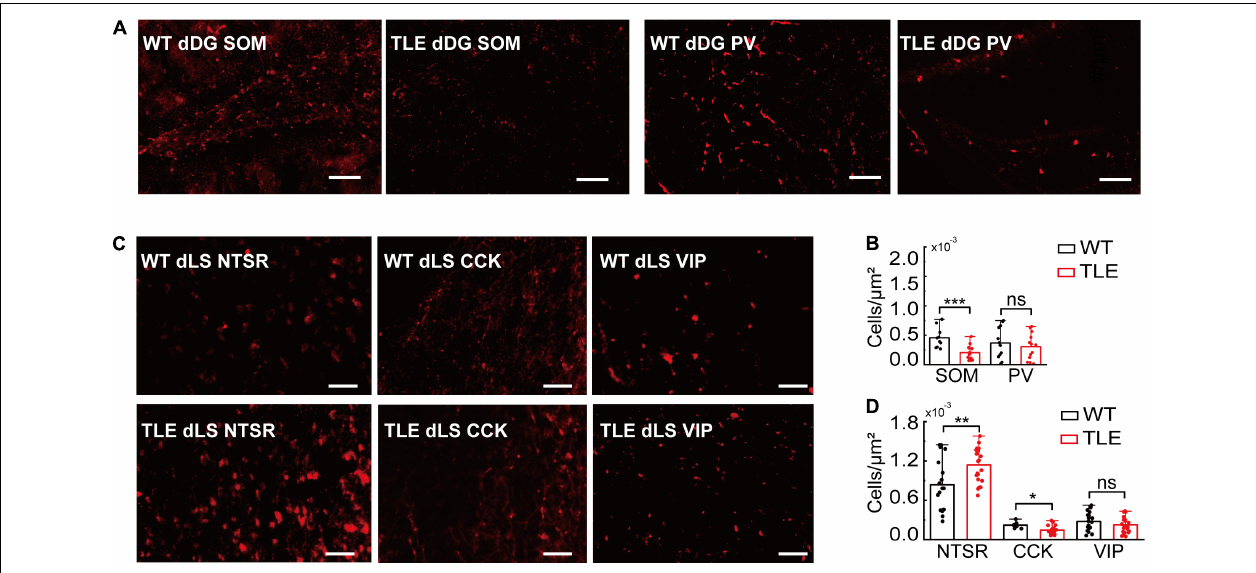
FIGURE 5 | Comparison of GABAergic neurons subtypes in WT vs. TLE. (A) Representative images of immunostaining of PV+ and SOM+ neurons in dDG of WT and TLE mice. Scale bar, 200 µ m. (B) The densities of SOM+ and PV+ neurons in dDG/CA3 (SOM+: WT, n = 6 mice, TLE, n = 6 mice; PV+: WT, n = 6 mice, TLE, n = 5 mice). (C) Representative images of immunostaining of NTSR+, CCK+, and VIP+ neurons in dLS of WT and TLE mice. Scale bar, 200 µ m. (D) The densities of NTSR+, CCK+, and VIP+ neurons in dLS (NTSR+: WT, n = 11 mice, TLE, n = 10 mice; CCK+: WT, n = 6 mice, TLE, n = 9 mice, VIP+: WT, n = 11 mice, TLE, n = 6 mice) (Error bars represent s.d; * p < 0.05; ** p < 0.01, *** p < 0.001, t-